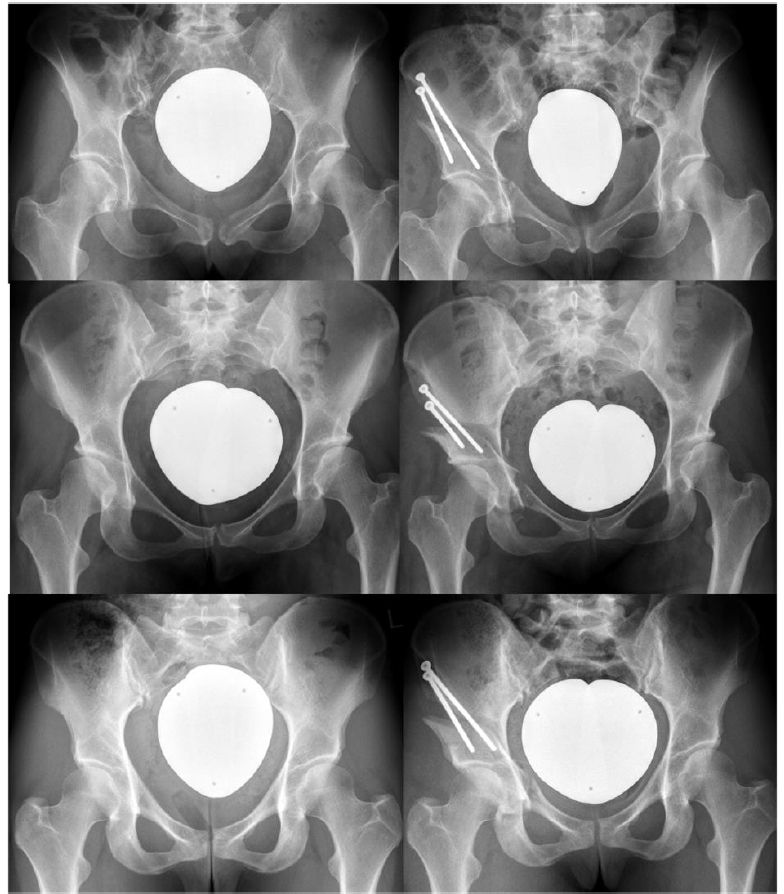
Figure 1. Three cases of periacetabular osteotomy. The preoperative X-ray is depicted on the left of each row, and the corresponding postoperative on the right. Note that due to the inherent stability of the construct, the first author of this review (SSA) generally uses only two 4.5 mm screws for fixation.